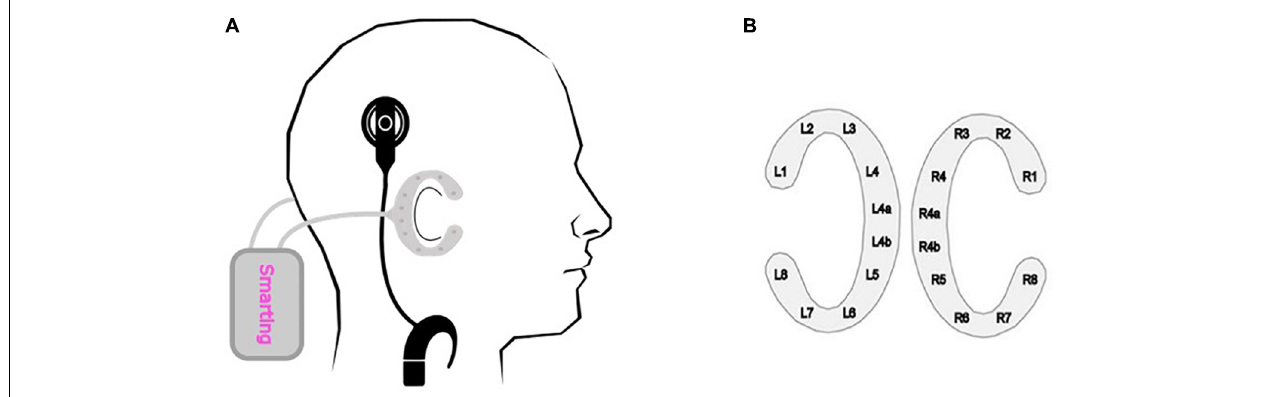
FIGURE 1 | cEEGrid recording. (A) Schematical placement of the cEEGrid system. The C-shaped cEEGrid arrays are fixated around the ear with a double-sided adhesive. Both cEEGrid arrays are connected to a wireless mobile 24-channel EEG amplifier (SMARTING, mBrainTrain, Belgrade, Serbia). The CI sound processors were moved from their usual position (behind the ear) to the participant’s collar, as otherwise the CI processors would have occupied the same position as the cEEGrid. (B) cEEGrid electrode layout. Each cEEGrid array consists of 10 single electrodes. Electrodes L1–L4 and L5–L8 around the left ear and electrodes R1–R4 and R5–R8 around the right ear measure the voltage between the respective electrode and the reference electrode R4b. Electrode R4a is the ground electrode. The electrode L4b was used in the offline analysis for re-referencing the data. In order to keep the layout symmetric, electrode L4a was excluded from the data analysis. Accordingly, 16 channels, 8 around each ear, were used for the